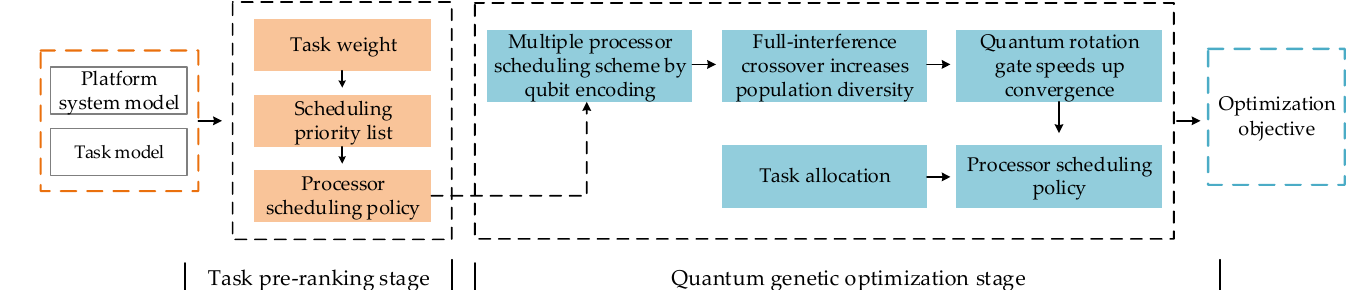
Figure 4. Design framework of HSP-QGA.